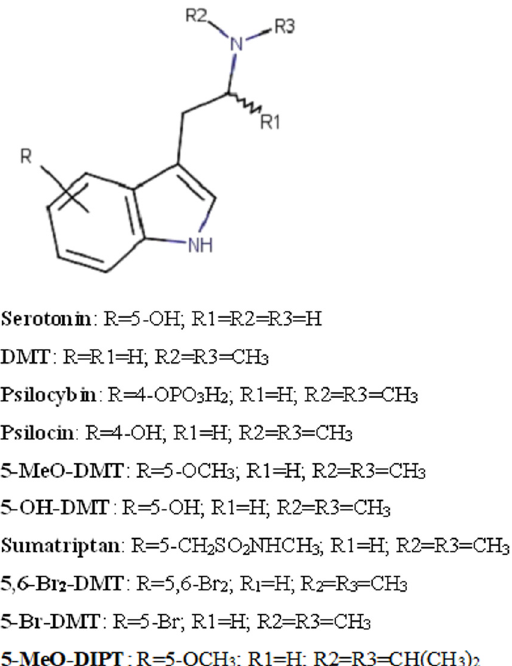
Figure 4: Generalized structure of a tryptamine derivative [ 409 ]